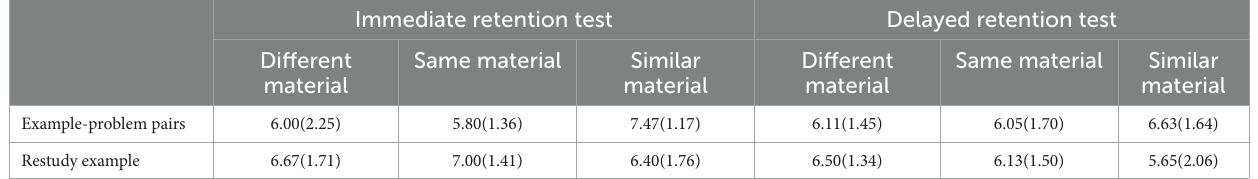
TABLE 4 The mental effort of retrieve practice on problem-solving under different material properties.